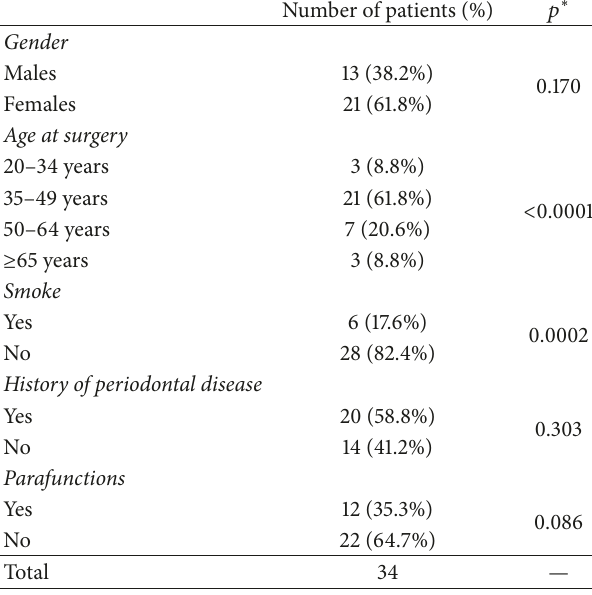
Table 1: Patient